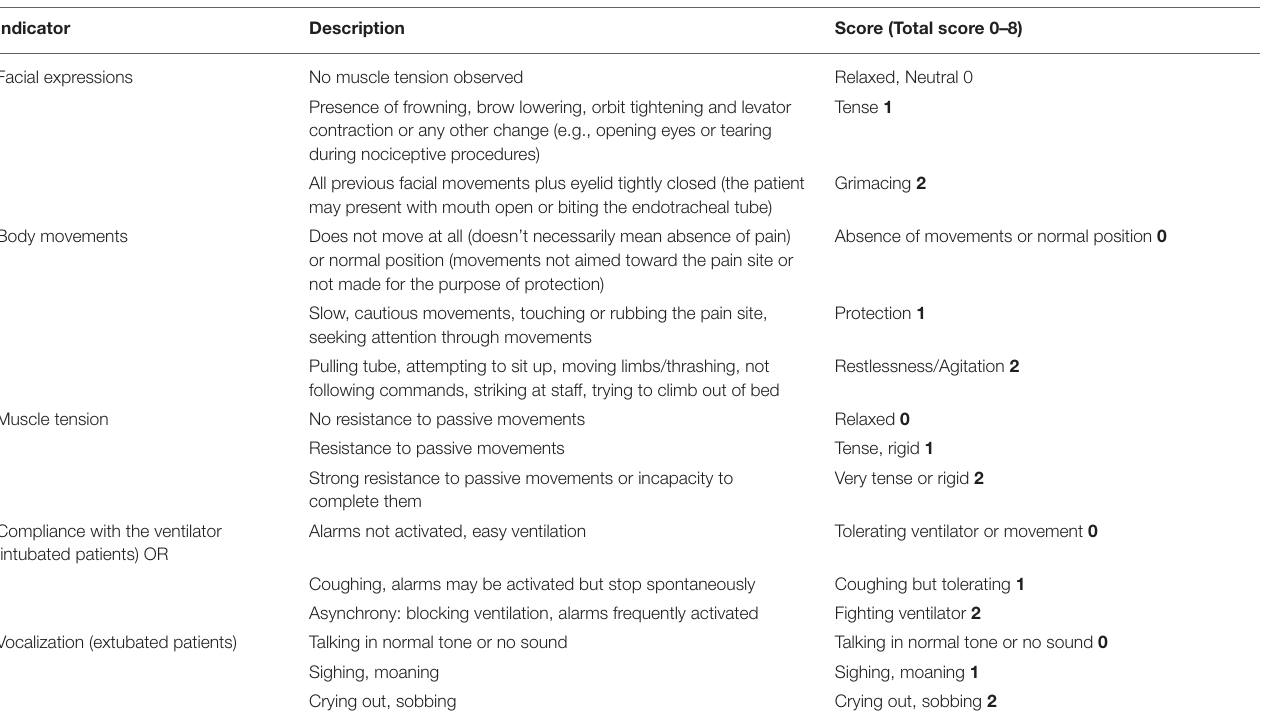
( Table 2 ) scores every 4 h after administration, RASS and CPOT scores every 8 h after the first 24 h, and RASS and CPOT scores every 24 h after the first 48 h; 4) time of awakening (RASS